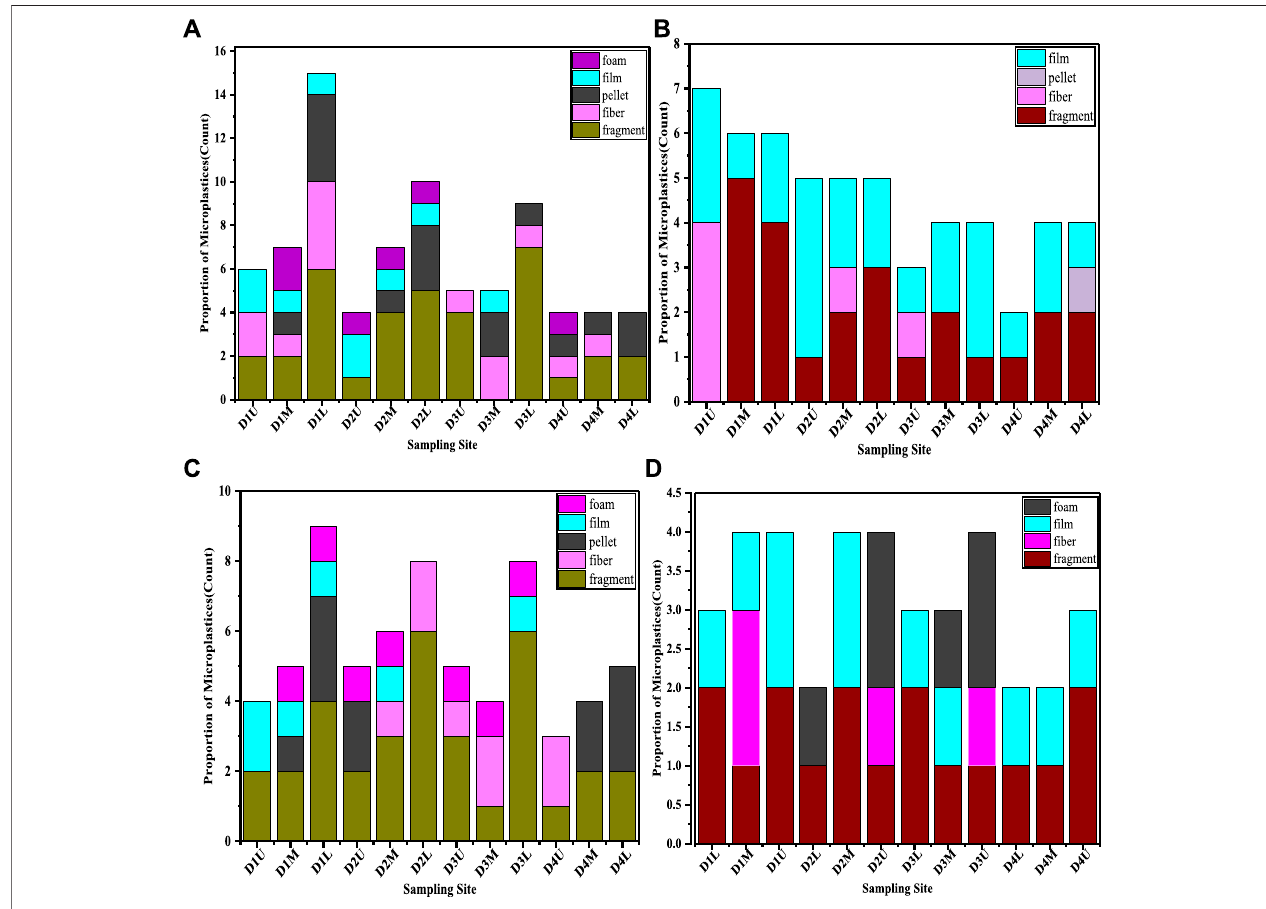
FIGURE4| MPsshapeproportionfromsediment (A,B) andagglomeratedsewagewatersamples (C,D) acrossallsamplinglocationsofeachditchforparticlesize < 0.5 mm (A,C) and > 0.5 mm (B,D) .